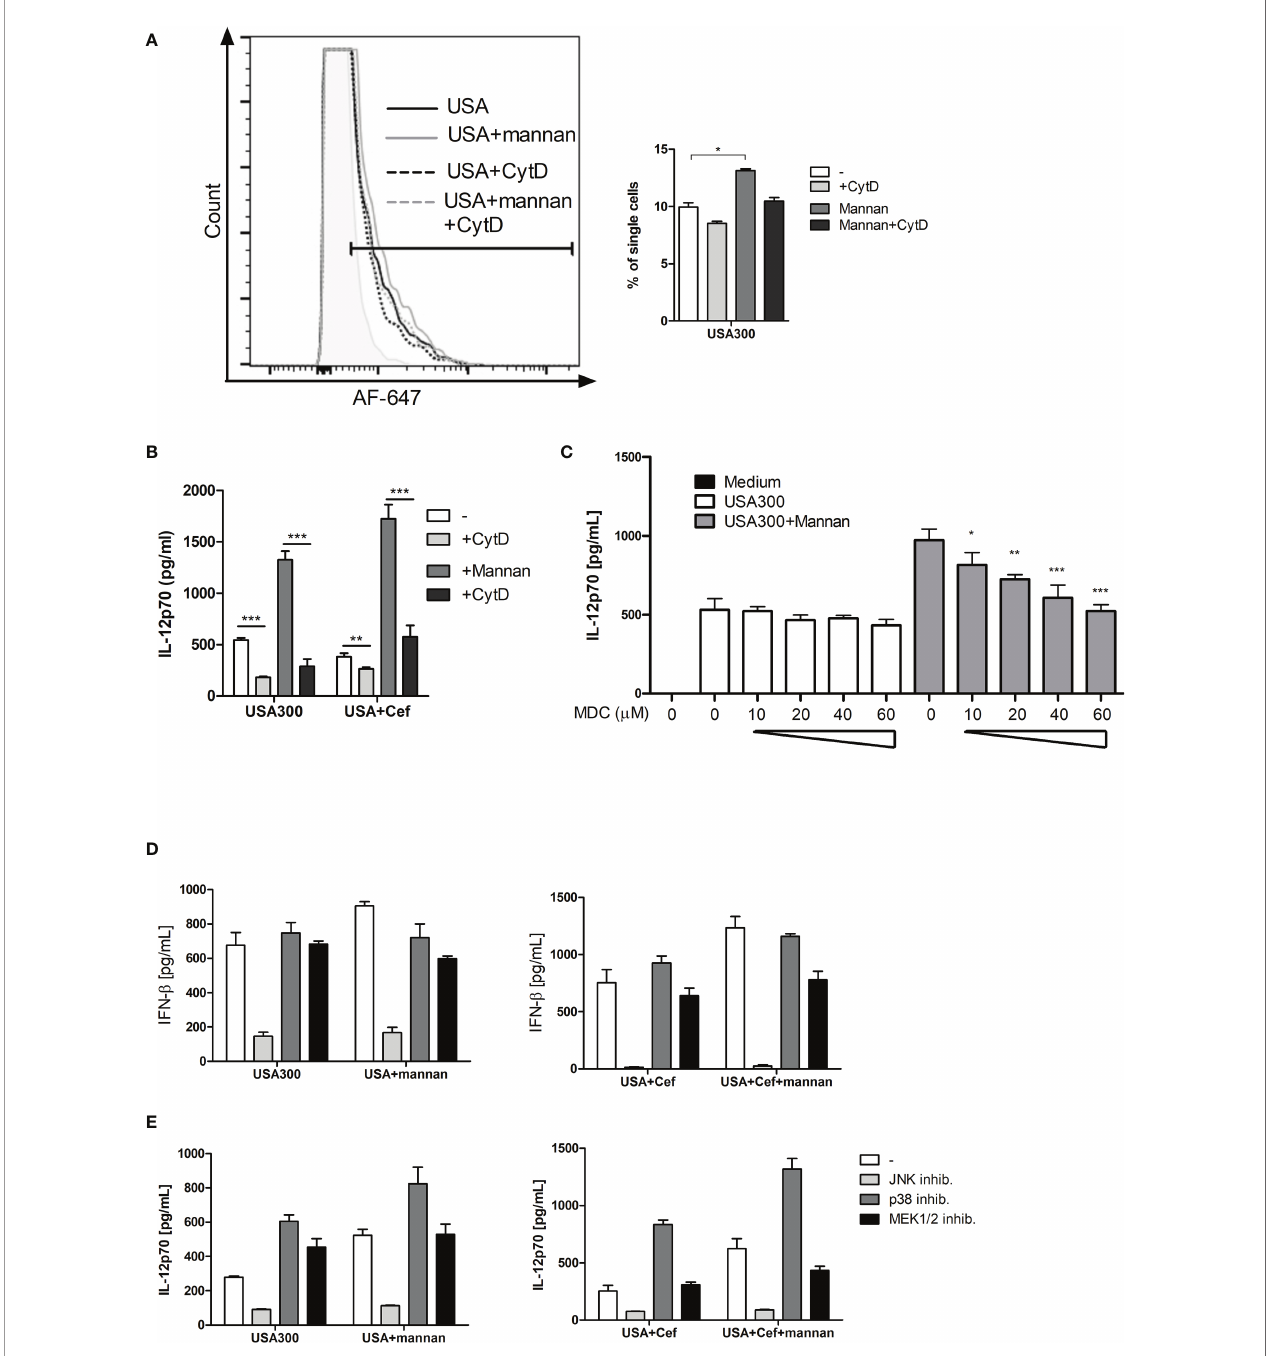
FIGURE 4 | The IL-12-enhancing effect of mannan is dependent on bacteria uptake and is abrogated by inhibition of clathrin-coated pits. DCs were pre-treated with CytD and/or mannan and infected with AF-647-labeled USA300 at MOI 50 for 1 h. Fluorescence intensity was measured by fl ow cytometry. Histogram shows a representative example of AF-647-USA300 uptake. Bar graph shows percentages of DCs taking up bacteria, paired t-test was performed on samples subtracted their respective CytD-treated samples (A) . DCs were treated with CytD for 1 h and treated with mannan 30 min prior to infection with USA300. Cytokines were measured in supernatant by ELISA (B) . DCs were treated with increasing concentration of monodansylcadaverine (MDC) and pre-treated (black bars) or not (white bars) with mannan prior to stimulation with USA300 MOI 10. IL-12 in the supernatant was measured by ELISA (C) . The effect of inhibition of MAP kinases on the IFN- b (D) and IL-12 (E) concentration in cell supernatants after USA300 stimulation with or without mannan pre-treatment. All data are based on three separately stimulated replicates and are representative of two or more experiments. *p < 0.05, **p < 0.01, ***p <